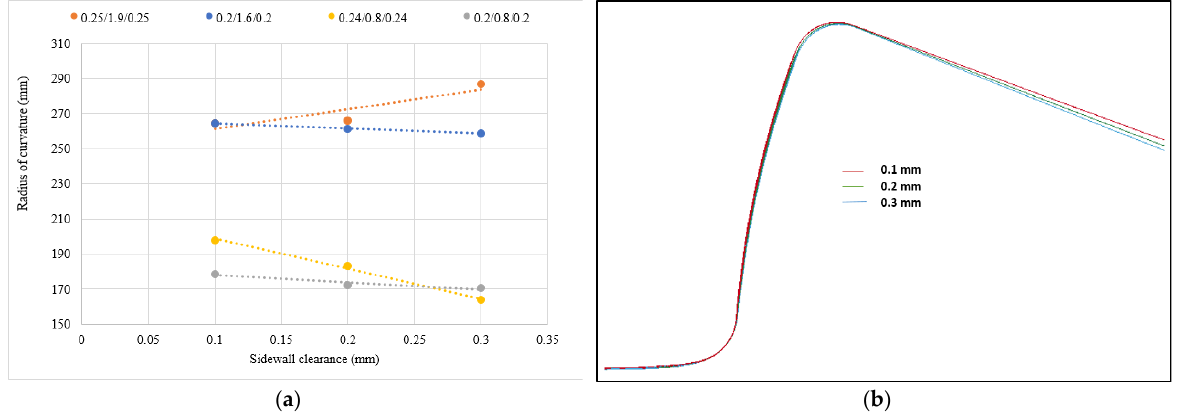
Figure 21. ( a ) Effect of sidewall clearance on radius of curvature and ( b ) U-channel profiles after springback for punch-die clearance of 0.1, 0.2 and 0.3 mm for a laminate with a thickness combination of 0.24/0.8/0.24 mm.